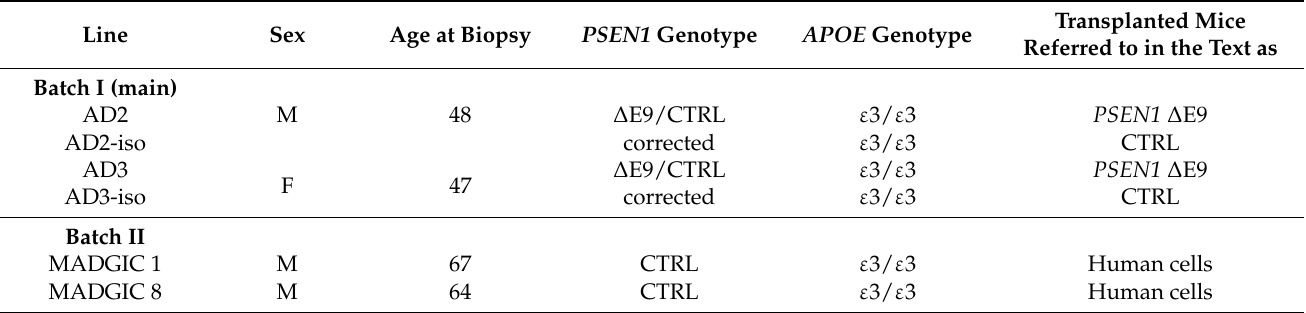
Table 1. Summary of the human-derived iPSC lines used in this